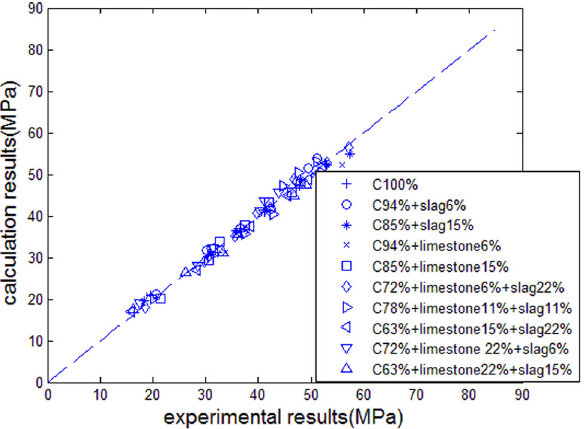
Fig. 10 Comparison between analysis results and experi- mental results.